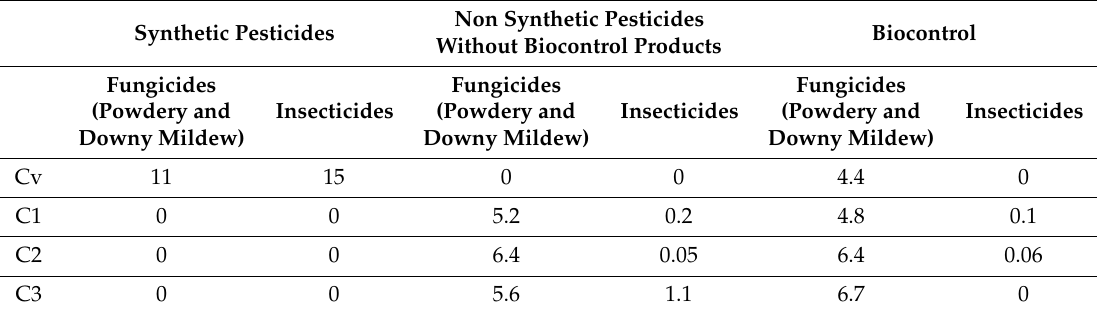
Table 1. Protection strategies (number of treatments) adopted for the four types of plots Cv, C1, C2, and C3. Synthetic pesticides were separated from not-synthetic pesticides and biocontrol products to take into account di ff erent modes of